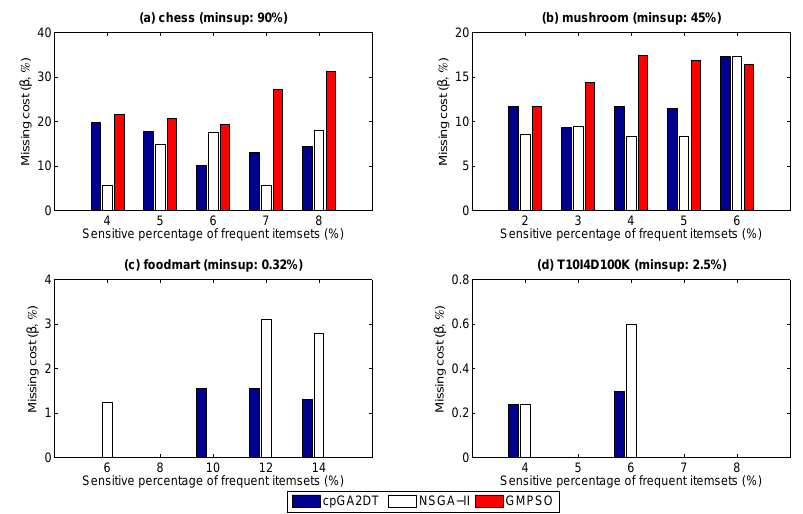
Figure 5. Missing cost under varied percentages of